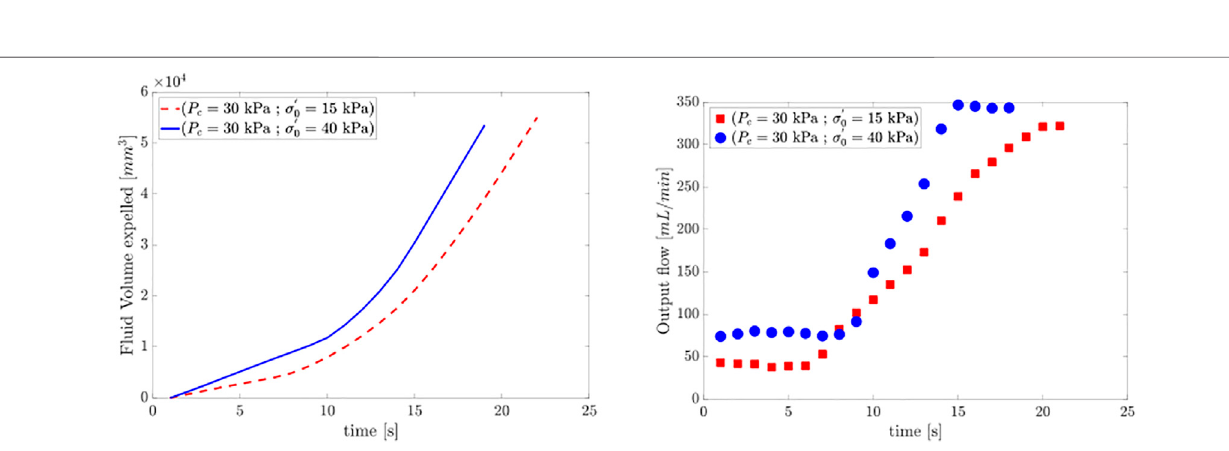
Frontiers in Physics |